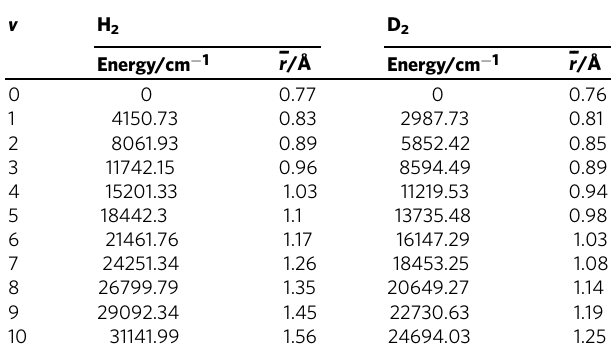
Table 2 The calculated energies and average bond lengths of vibrational states for H 2 (X 1 Σ g + ) and D 2 (X 1 Σ g +